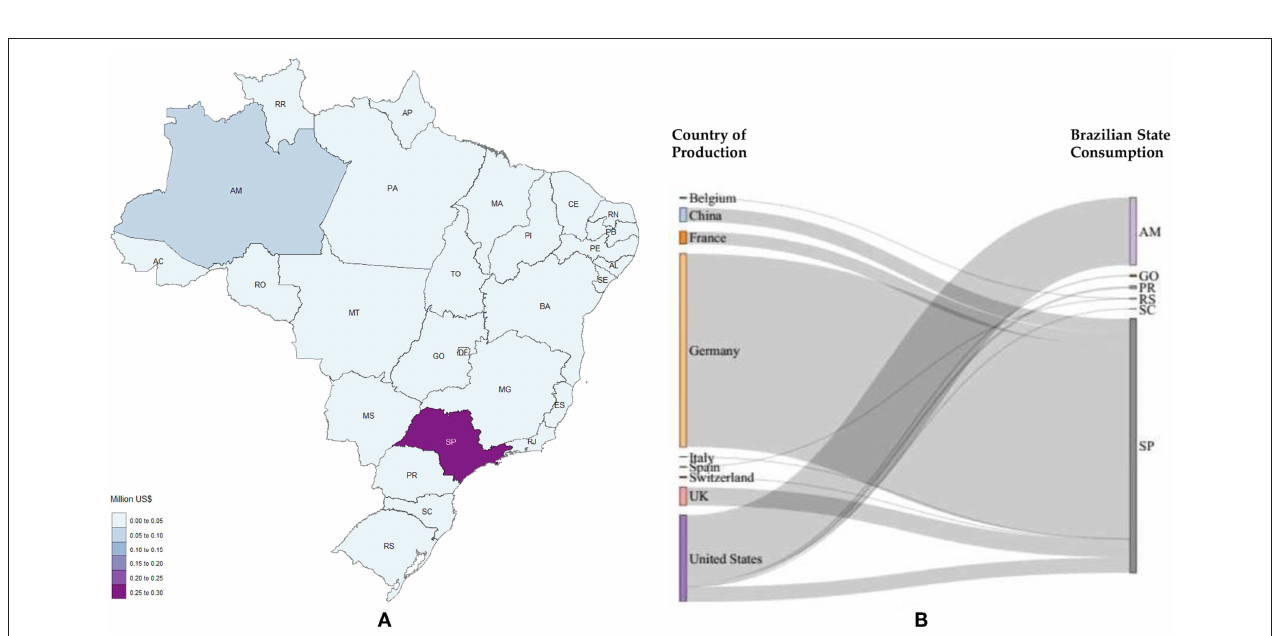
FIGURE 10 | Formic Acid imports. (A) Local needs considering 2017; (B) Stratification for 2017, countries on the left represent the origin of the product studied and the states on the right represent the destination (BA, Bahia; CE, Ceará; GO, Goiás; MT, Mato Grosso; MS, Mato Grosso do Sul; MG, Minas Gerais; PA, Pará; PB, Paraíba; PR, Paraná; PE, Pernambuco; RJ, Rio de Janeiro; RS, Rio Grande do Sul; RO, Rondônia; SC, Santa Catarina; SP, São Paulo; TO, Tocantins).